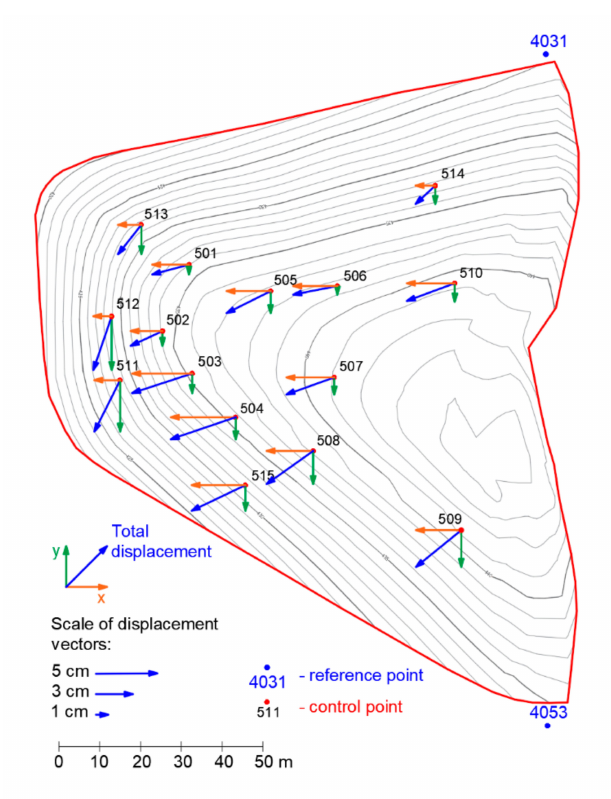
Figure 6. Map of vertical displacements of the landfill surface.